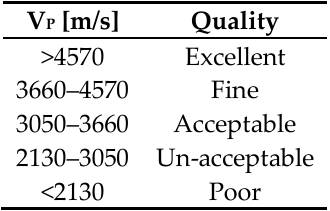
Table 4. Quality indicator